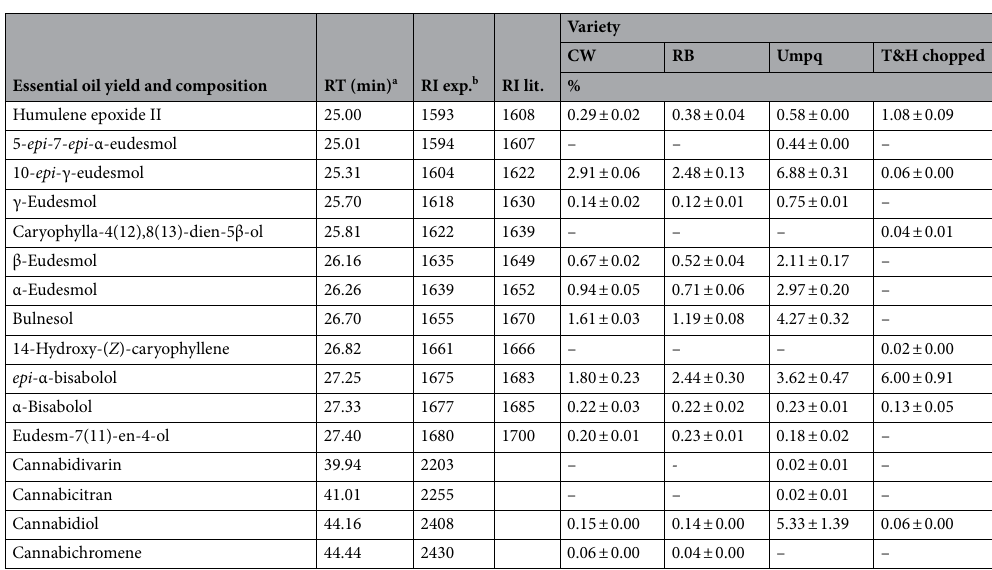
Table 1. Essential oil yield and composition obtained by non-stop steam distillation for 240 min of autoflower type hemp biomass of Cherry Wine organic (CW), Red Bordeaux organic (RB), Umpqua organic (Umpq), and non-stop steam distillation for 120 min of chopped biomass of autoflower type hemp T&H. a Temperature- programmed linear retention index experimentally determined by comparison with a mixture of C 8 -C 30 n -alkanes. b RI value taken from Adams (2007).